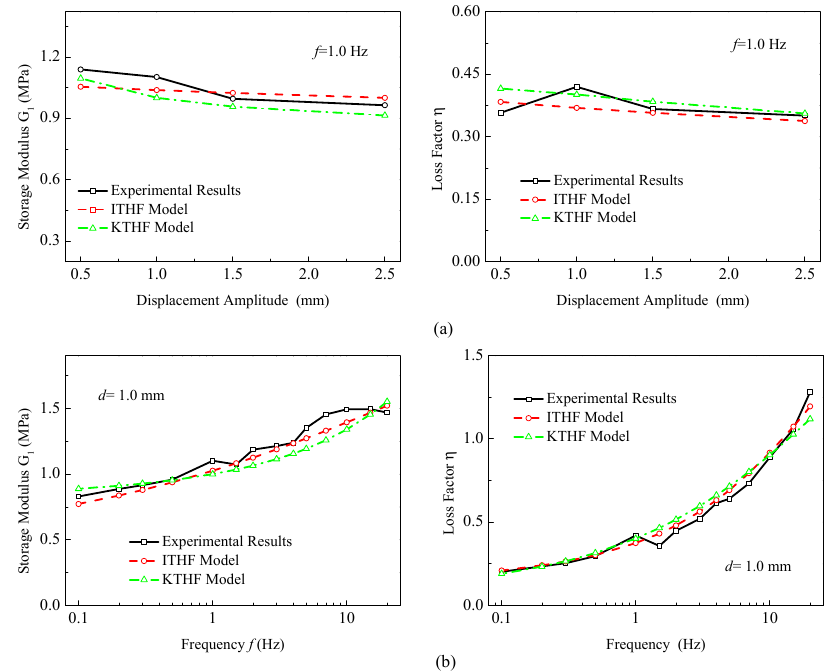
Figure 8. Comparisons of test data and numerical results for ITHF model and KTHF model. ( a ) f = 1.0 Hz. ( b ) d = 1.0 mm.